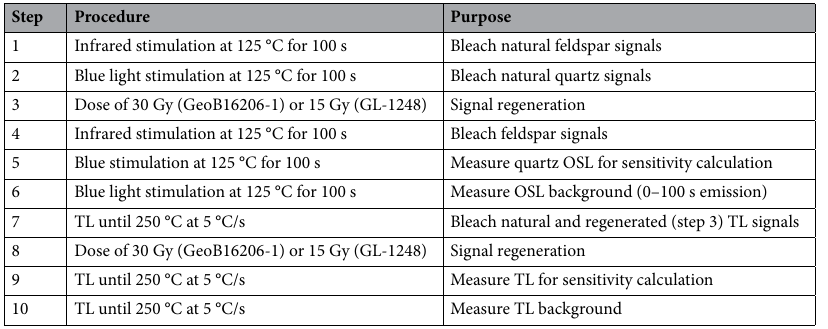
Table 1. Protocol used to measure thermoluminescence (TL) and optically stimulated luminescence (OSL) sensitivities in marine sediment cores GL-1248 and GeoB16206-1 21